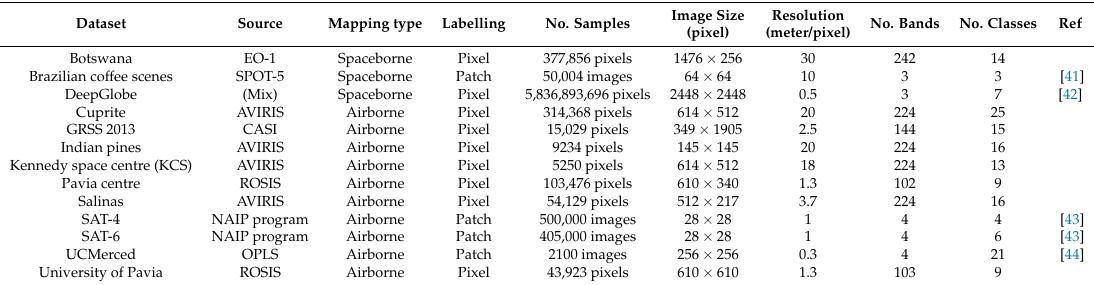
Table 2. Summary of the most popular multispectral and hyperspectral